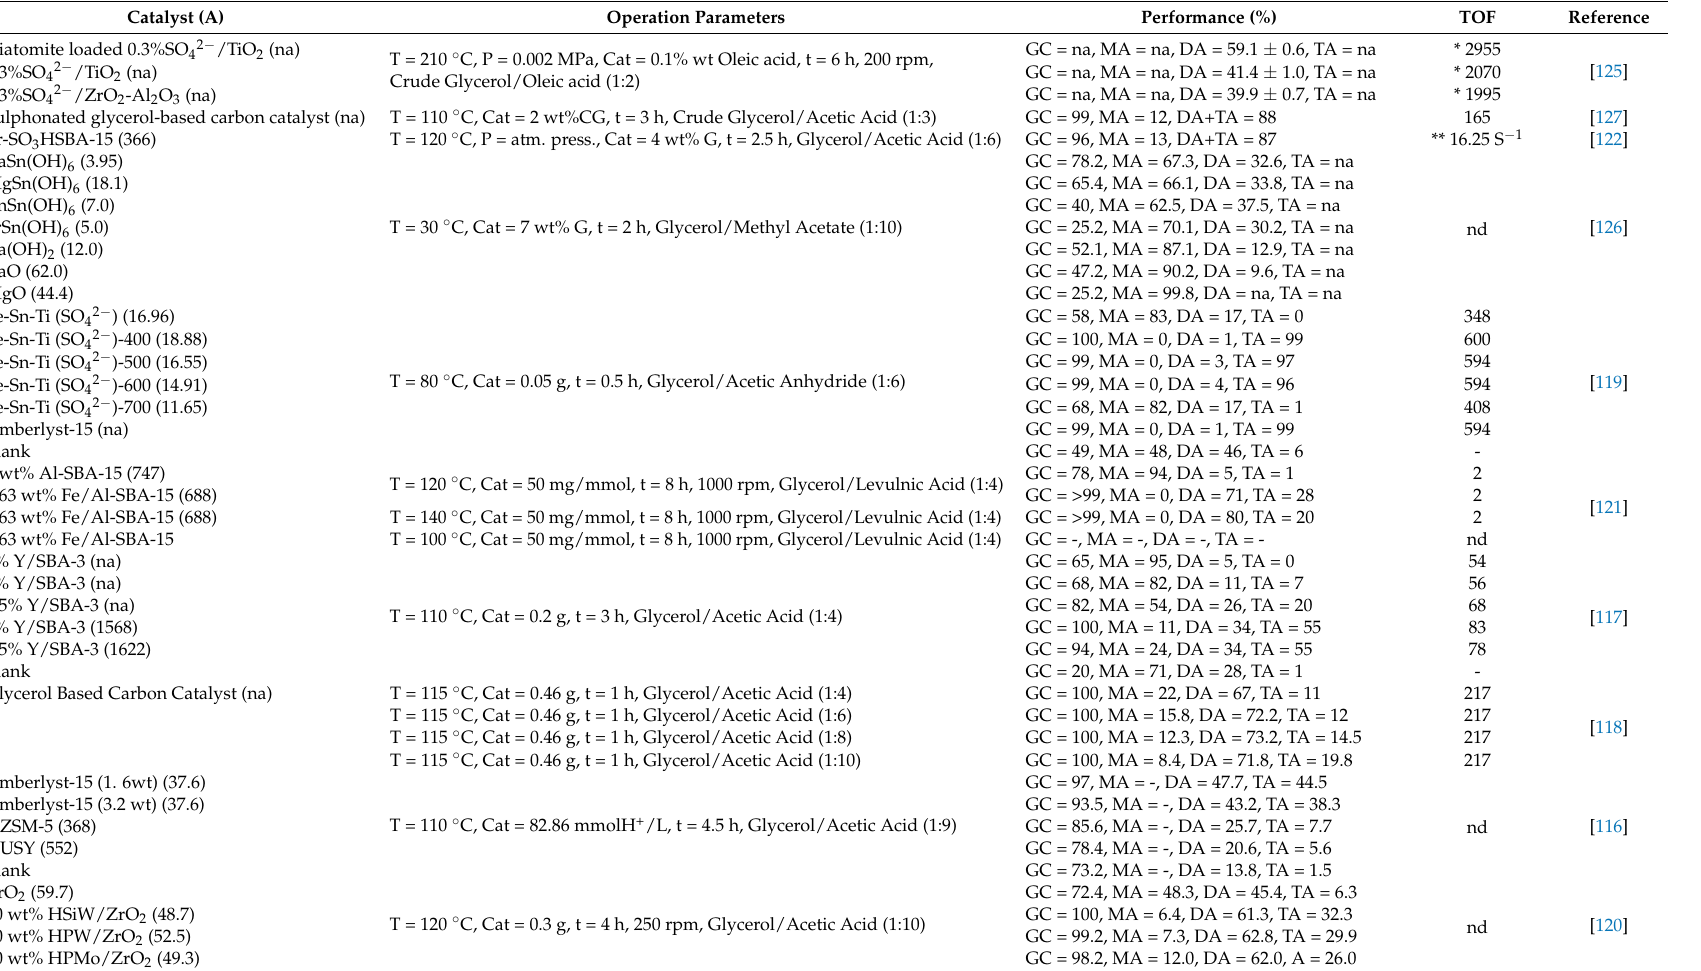
Table 8. Performance of some catalysts in the conversion of glycerol to acetin as reported in some